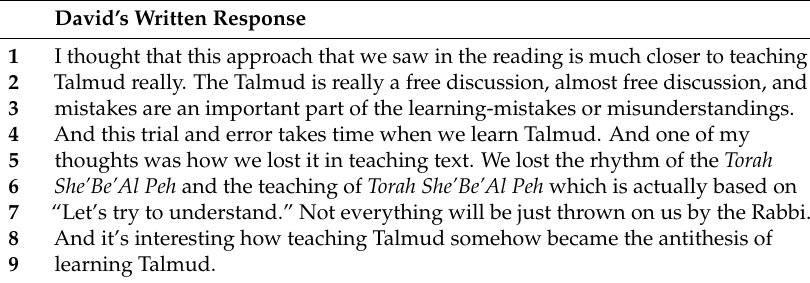
Table 2. David’s